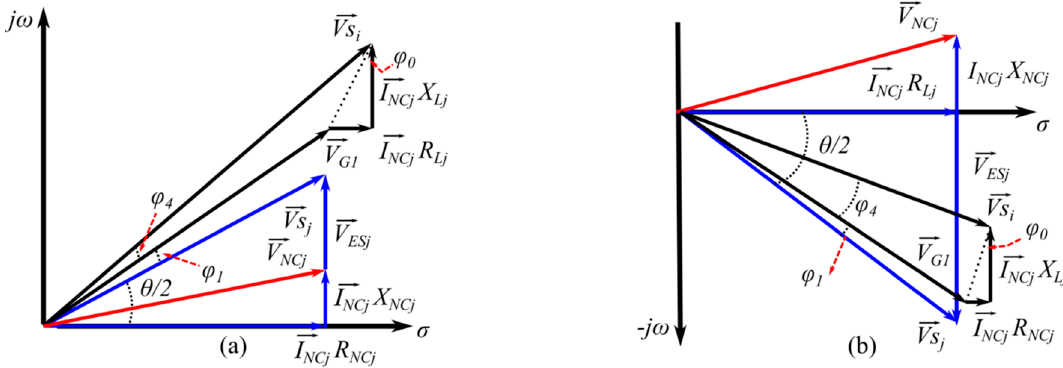
Figure 5. Geometric relationships of the ES model for ( a ) inductive operation mode and ( b ) capacitive operation mode.